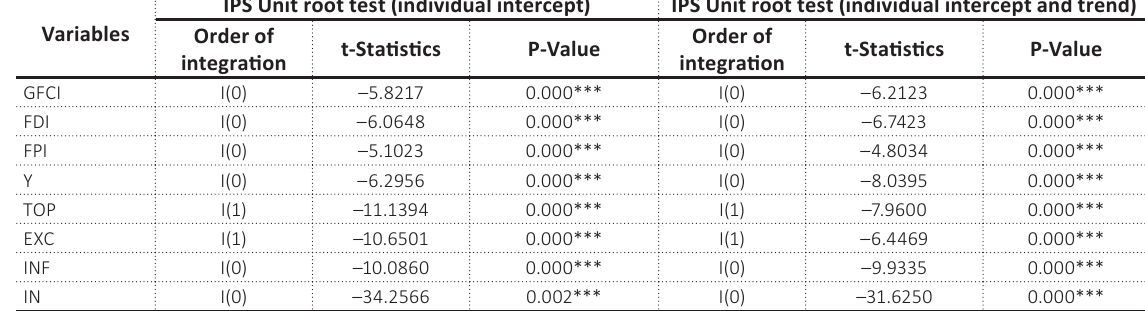
Table 3 (cont.). LLC, IPS and Augmented ADF unit root